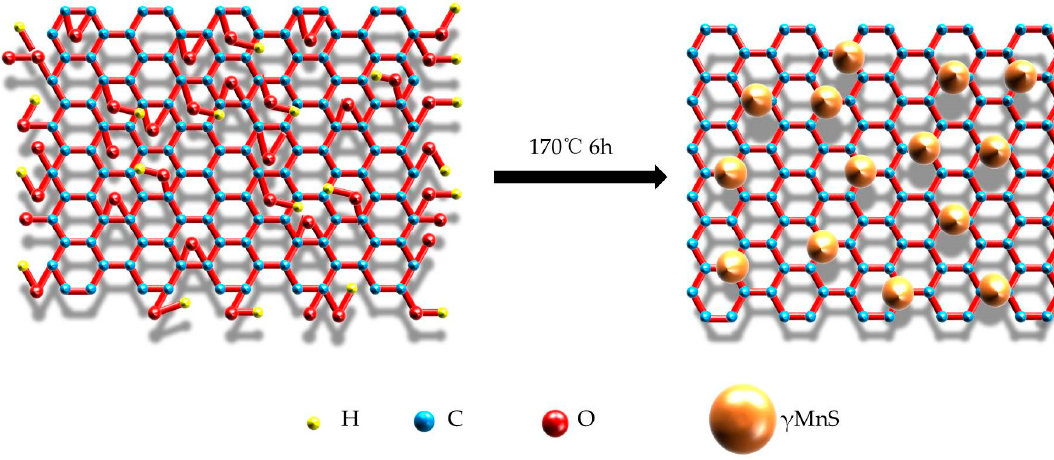
Figure 1. The process of γ MnS attached in GO.